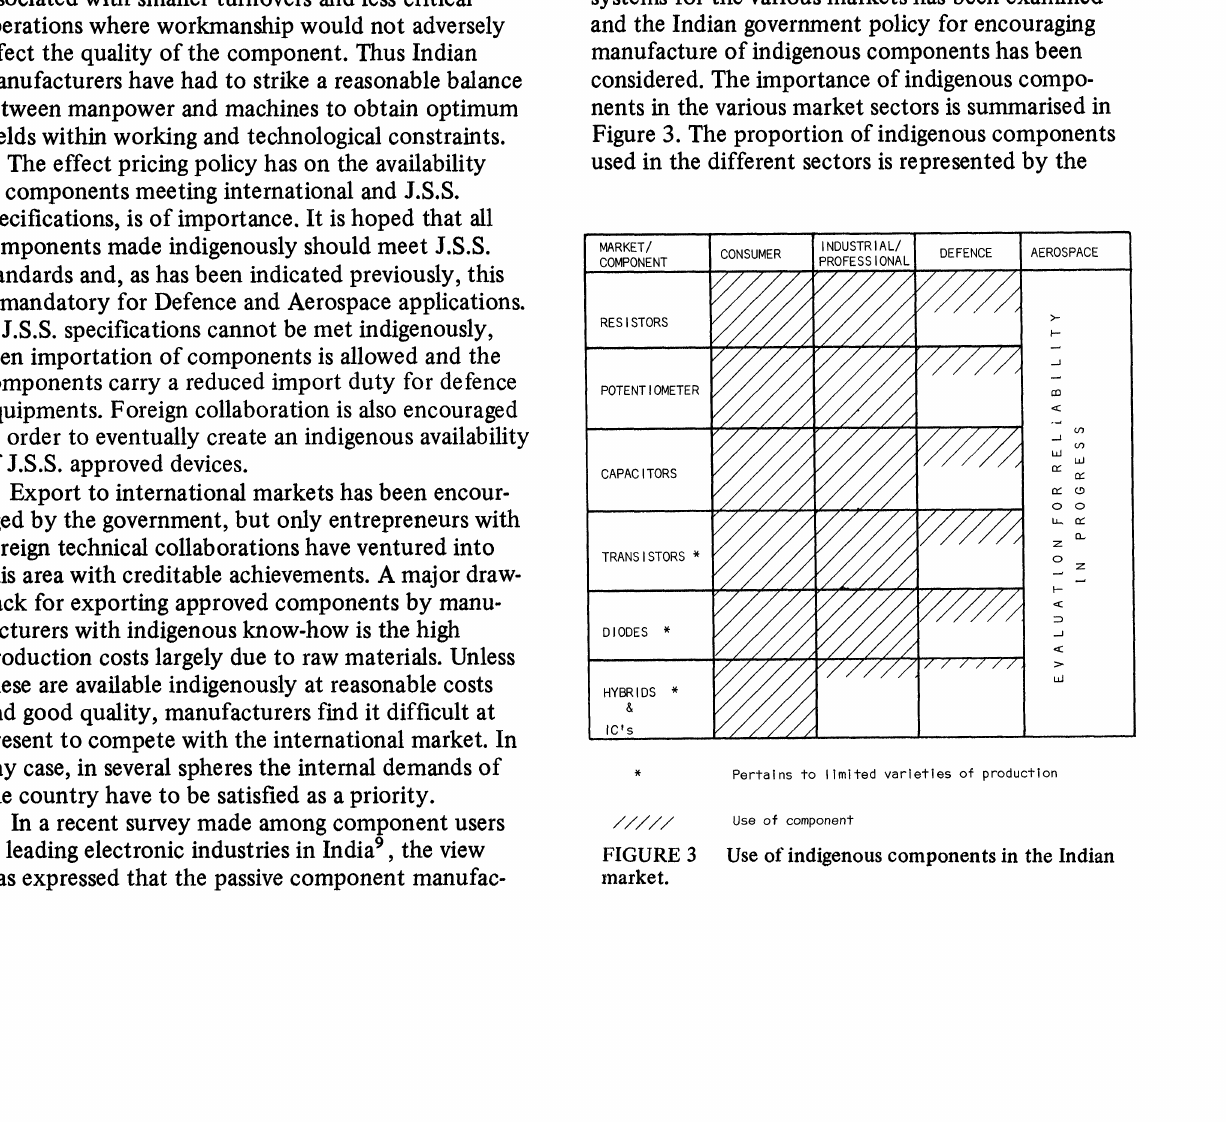
Figure 3. The proportion of indigenous components used in the different sectors is represented by the